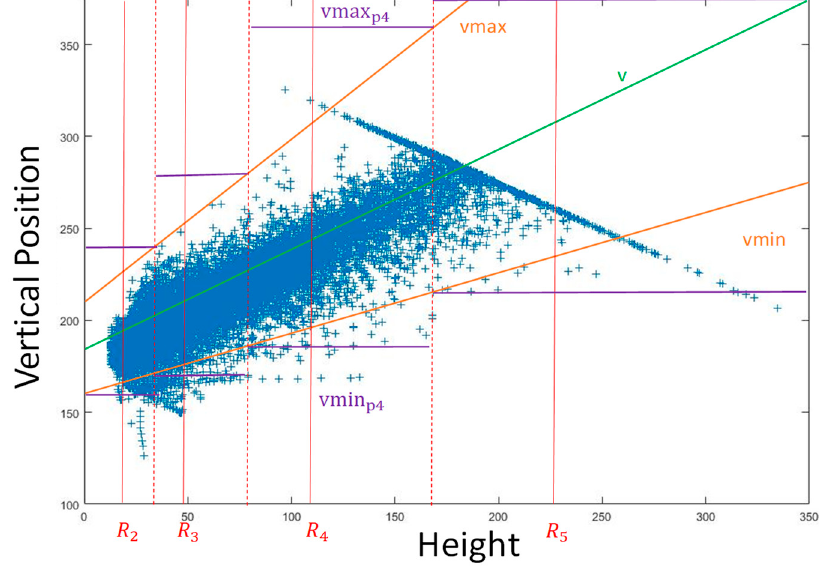
Figure 5. Our method to determine which part of the image a feature map should be involved in the region proposal stage.